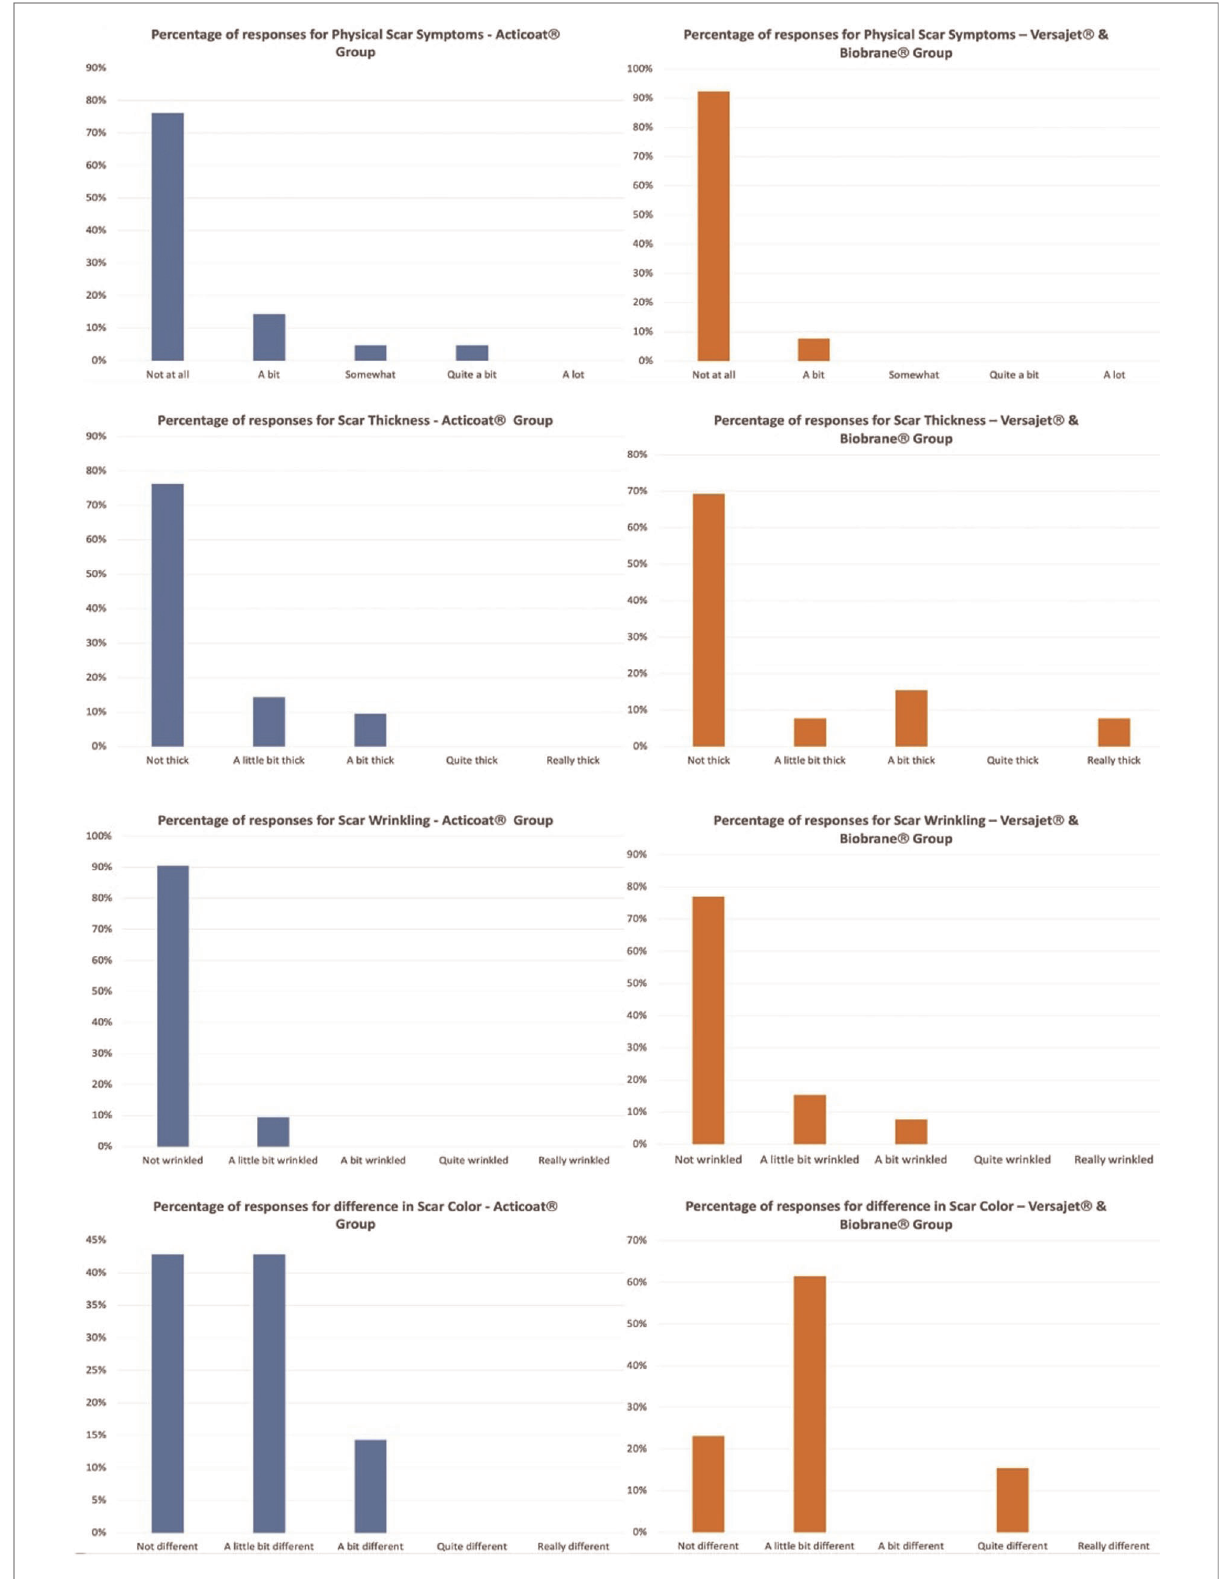
FIGURE 2 Percentage responses for worst scar physical